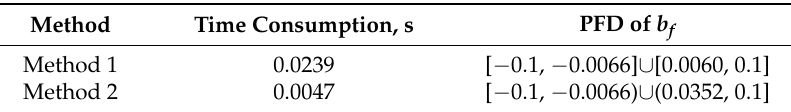
Table 1. Results of PFD via the two